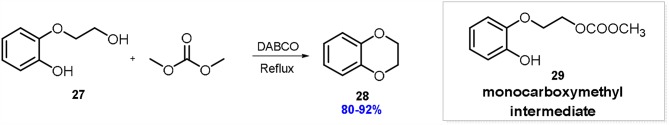
Preparation of 2,3-dihydrobenzo[b]-[1,4]dioxine 28 via DMC chemistry. Reaction conditions: 29: DMC: DABCO in 1.00: 8.00: 0.05–1.00, at 90°C for 2–15 h.